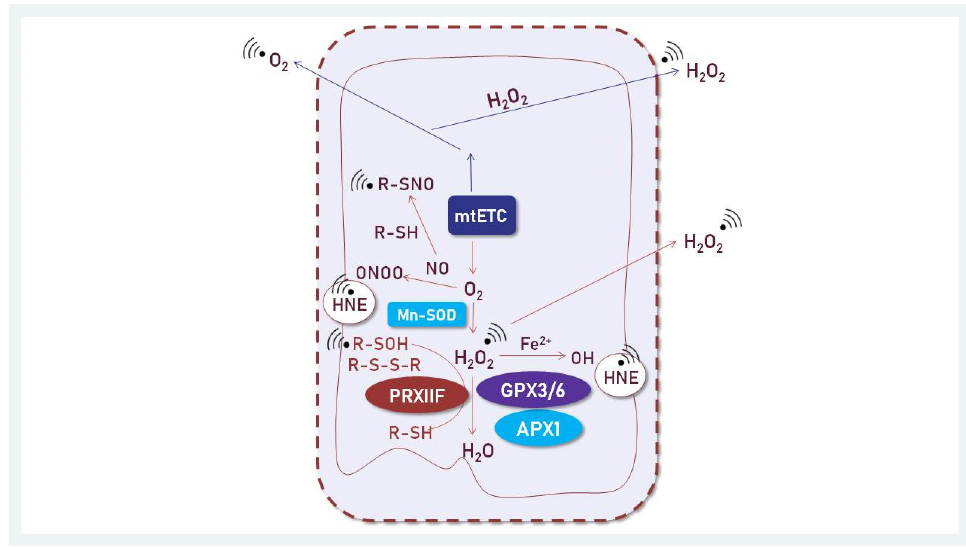
Figure 2. Mitochondrial ROS defense system. Redox metabolism is associated with the generation of reactive oxygen and nitrogen species (ROS, RNS). The mitochondrial electron transport chain (mtETC) is a major ROS generator. The process of ROS elimination and redox signal integration involves mitochondrial antioxidant enzymes such as manganese superoxide dismutase (MnSOD) and ascorbate-dependent peroxidase (APX). MnSOD, APX and thiol peroxidases of the PRX and